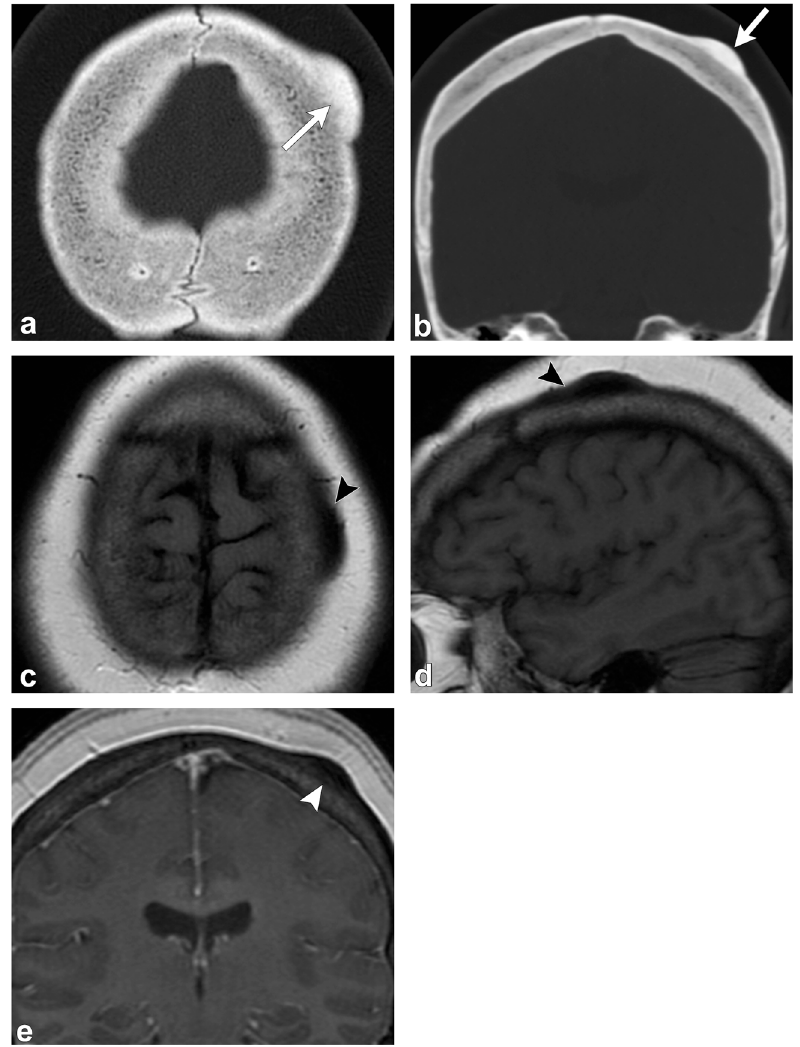
Fig. 3 Osteoma. Axial ( a ) and coronal ( b ) head CTimages show a juxta-cortical lesion along the outer table of the left frontal bone ( arrows ). Axial T1-weighted ( c ), sagittal T1-weighted ( d ) and coronal post-contrast T1- weighted ( e ) images depict the sclerotic/osteoblastic nature of this lesion ( arrowheads ). Note the well-defined margins and lack of